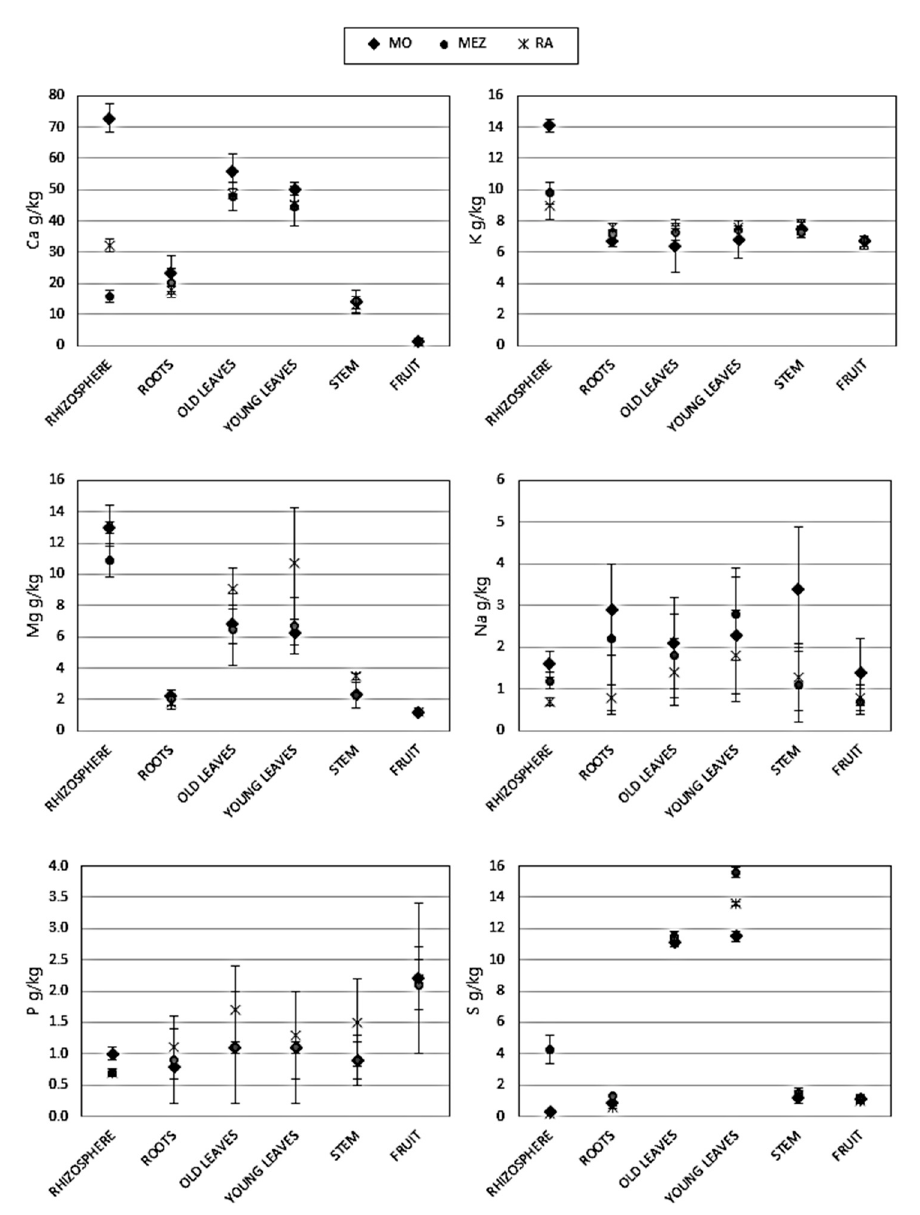
Figure 3. Ca, K, Mg, Na, P and S concentrations in rhizosphere soil, root, old and young leaves, stem and fruit of processing tomato plants cultivated in Modena (MO), Ferrara (MEZ) and Ravenna (RA) provinces, Emilia Romagna Region, Italy. Error bars represent standard error of the mean.